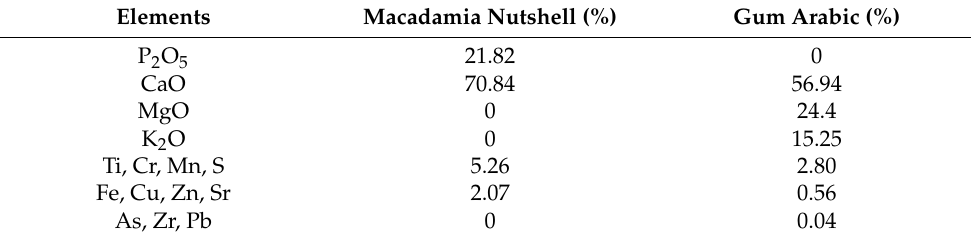
Table 3. Chemical properties of macadamia nutshell particles and gum